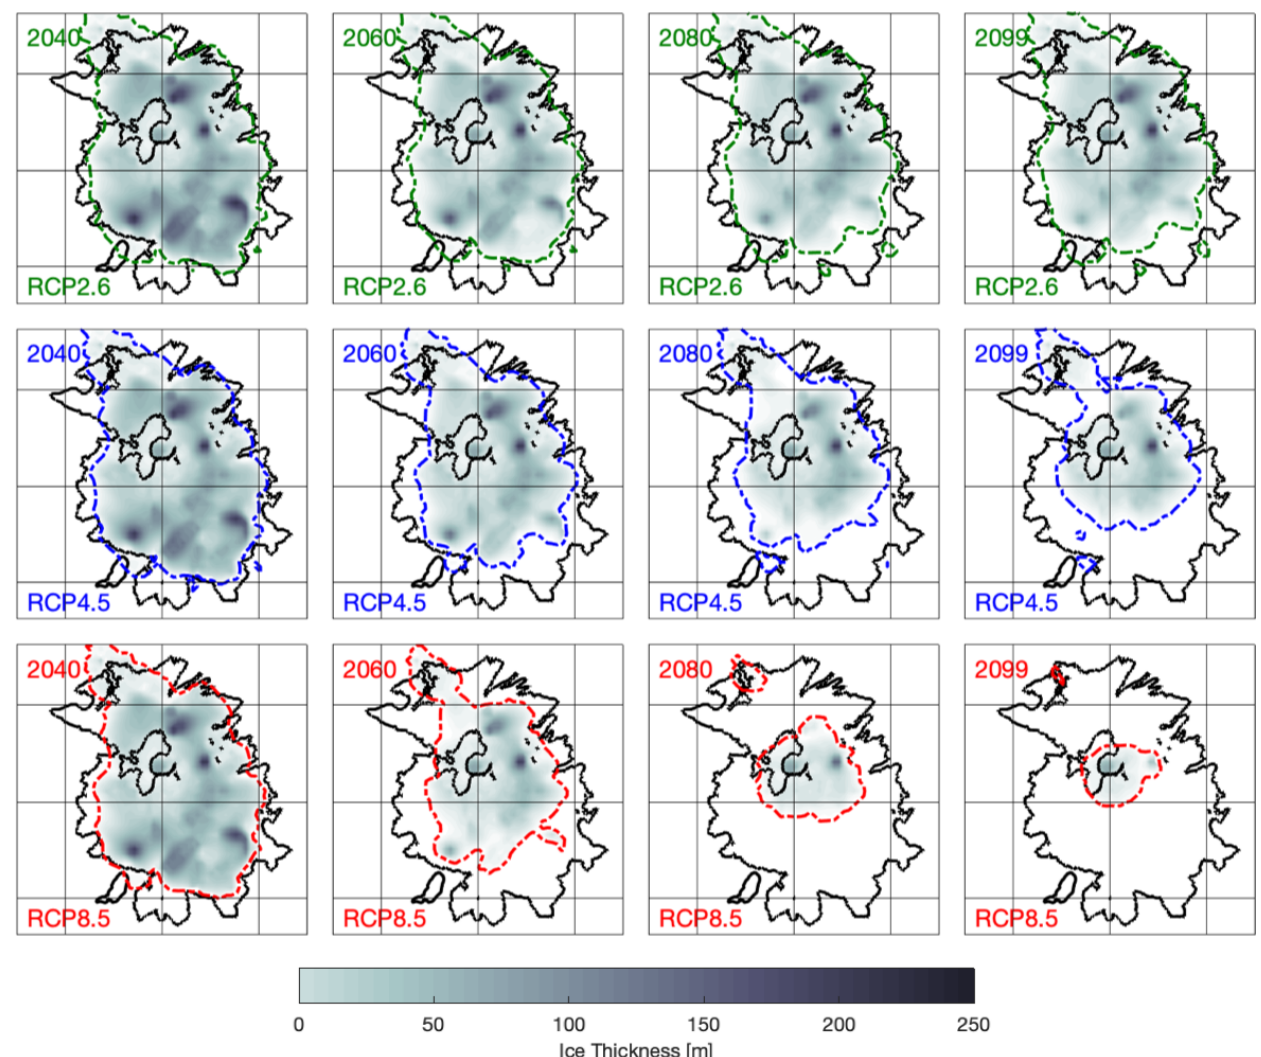
Figure 9. Ensemble mean ice thickness for three different future temperature scenarios and four different years obtained by averaging the thickness obtained from all 23 climate models in every grid cell. The dashed coloured lines show modelled ice extent, and solid black lines show the observed ice extent in